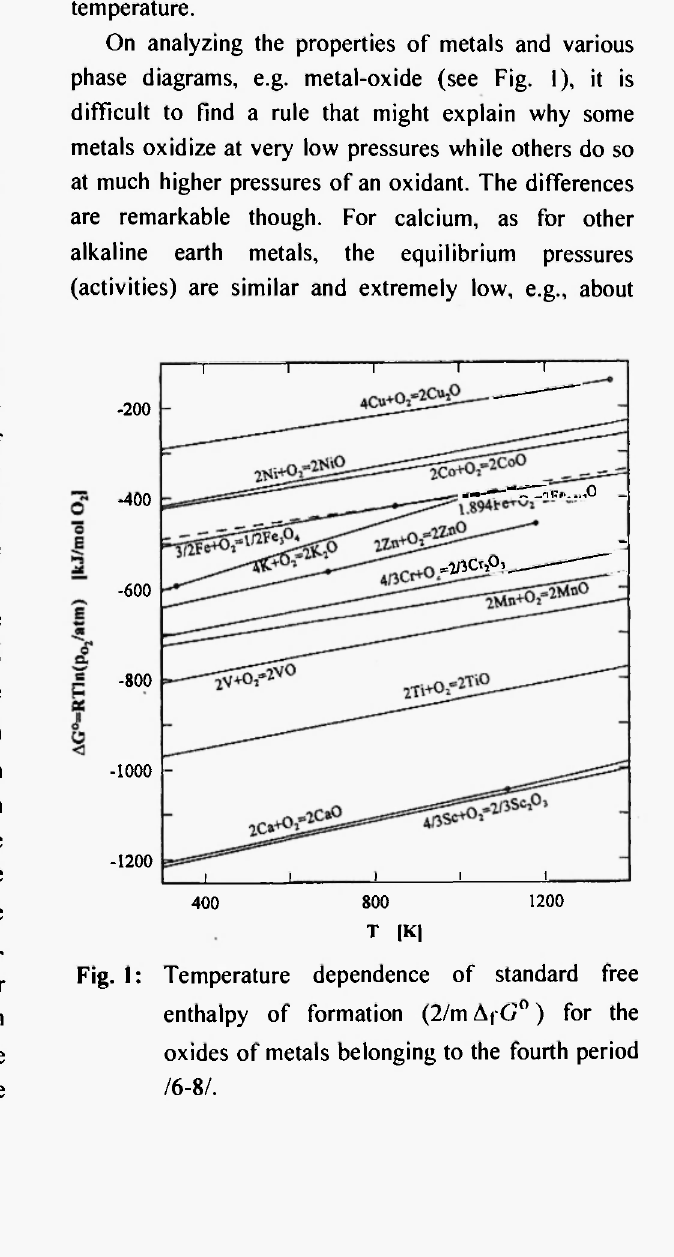
Fig. 1: Temperature dependence of standard free enthalpy of formation (2/m AfC7°) for the oxides of metals belonging to the fourth period